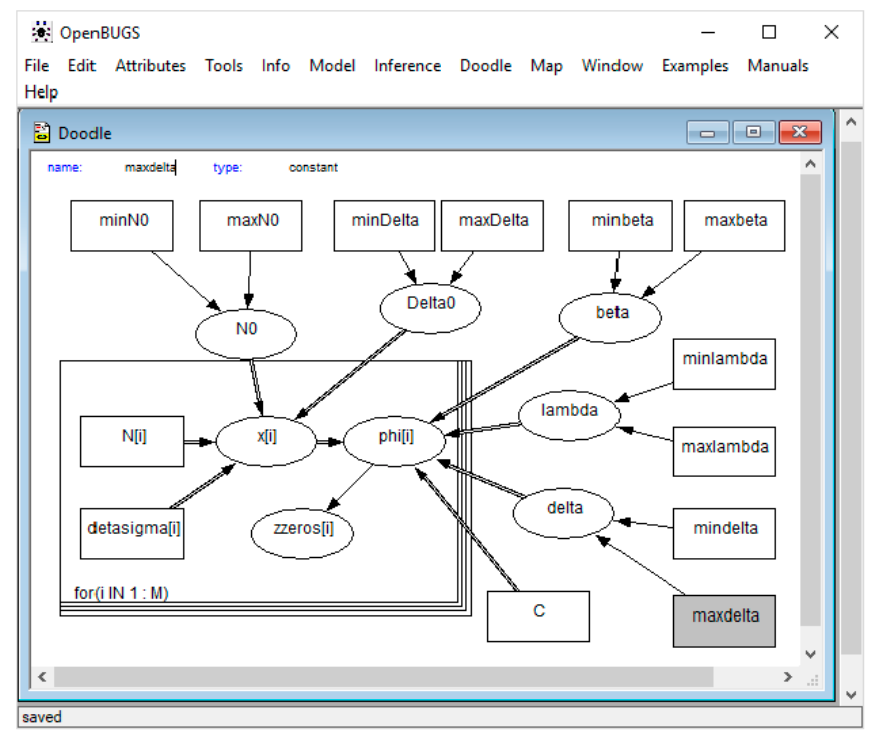
Figure 4. Block diagram of the Castillo and Canteli model introduced with Graphic Doodle in OpenBUGS.